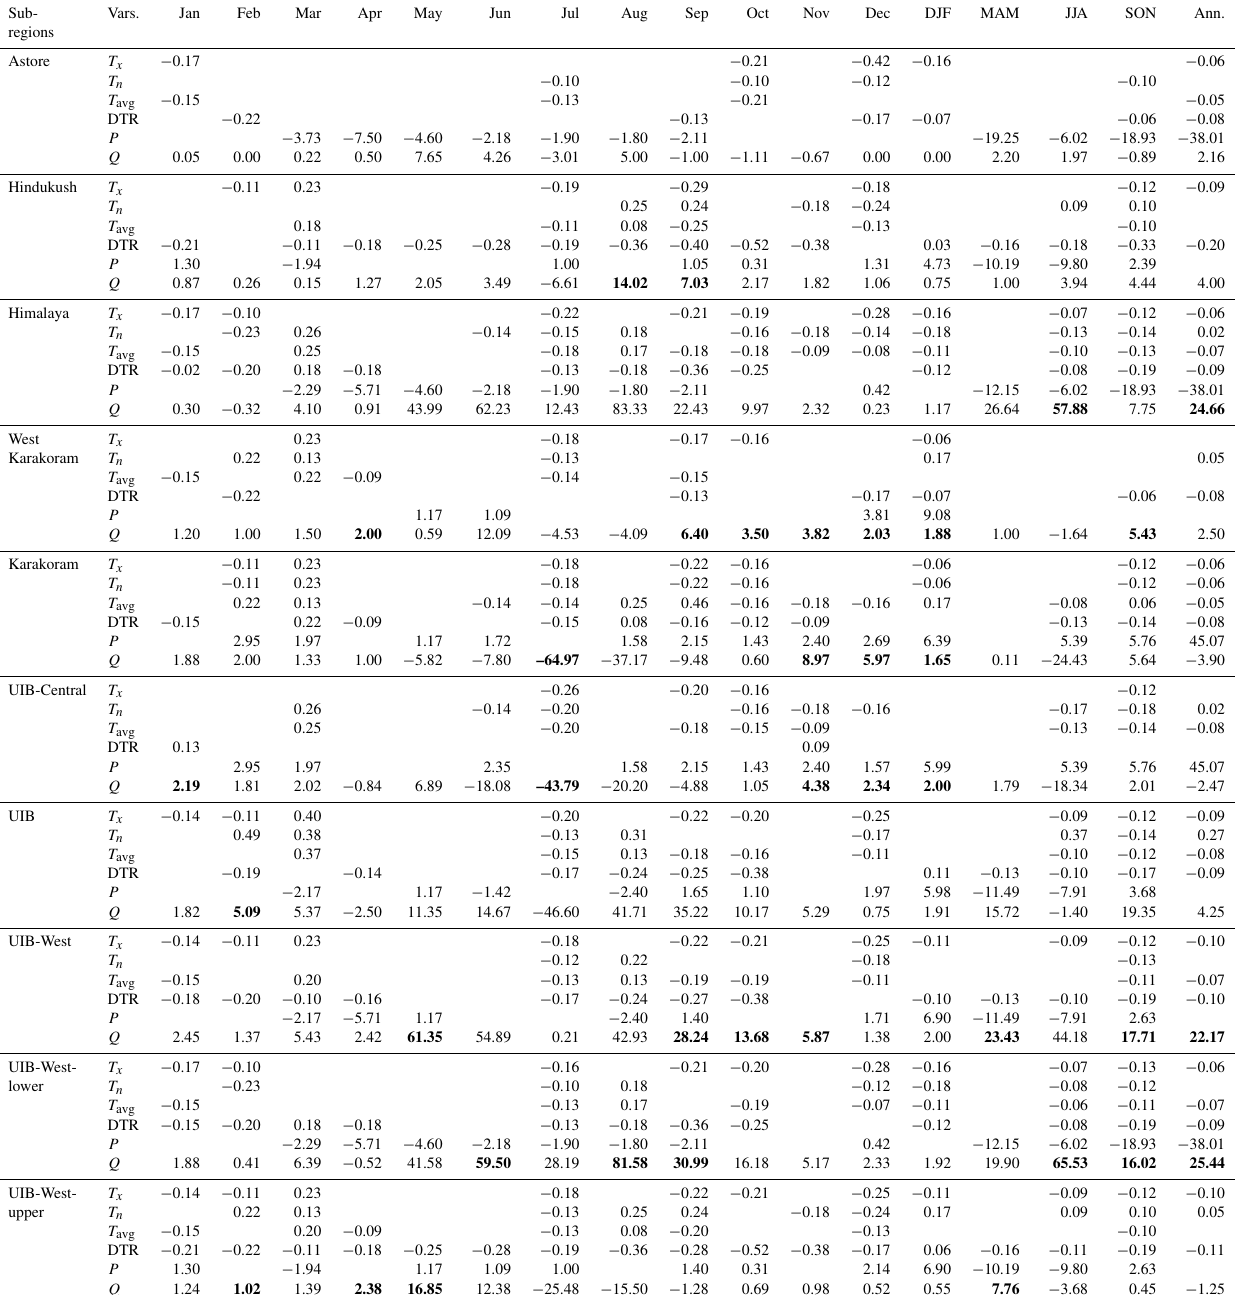
Table 7. Field-significant climatic trends for 10 subregions along with their discharge ( Q ) trends at monthly to annual timescales over the period 1995–2012. Bold Q values indicate significant trends at the 90% level. Sub- Vars. Jan Feb Mar Apr May Jun Jul SON Ann. regions Astore